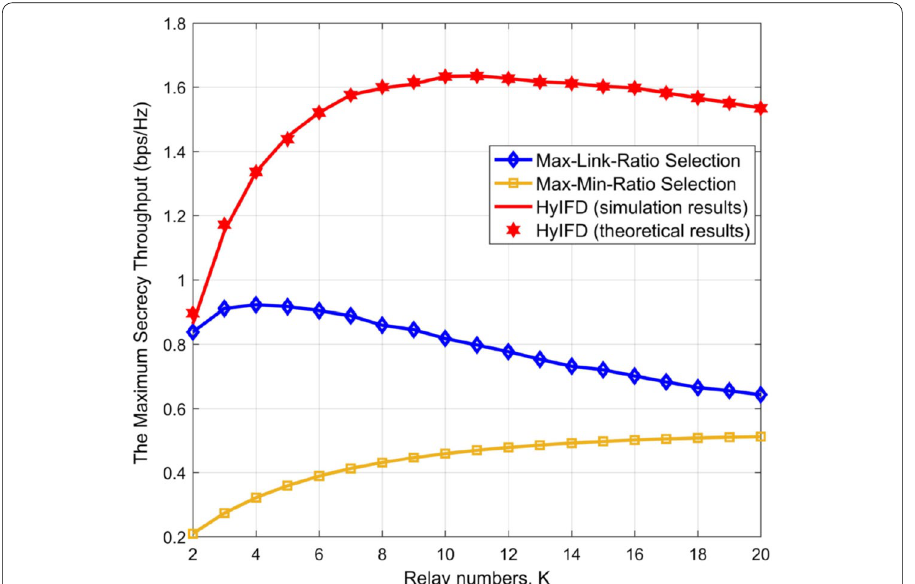
Fig. 4 The maximum secrecy throughput versus number of relays for different relaying protocols